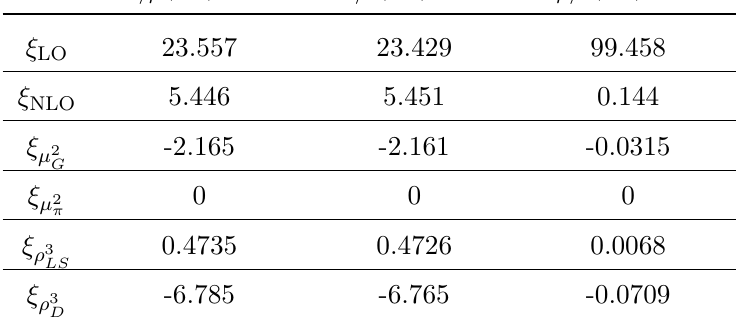
Table 2 . SM predictions for the inclusive LFU ratios. We list the different contributions indepen- dently of the value of the HQE parameters and separated according to